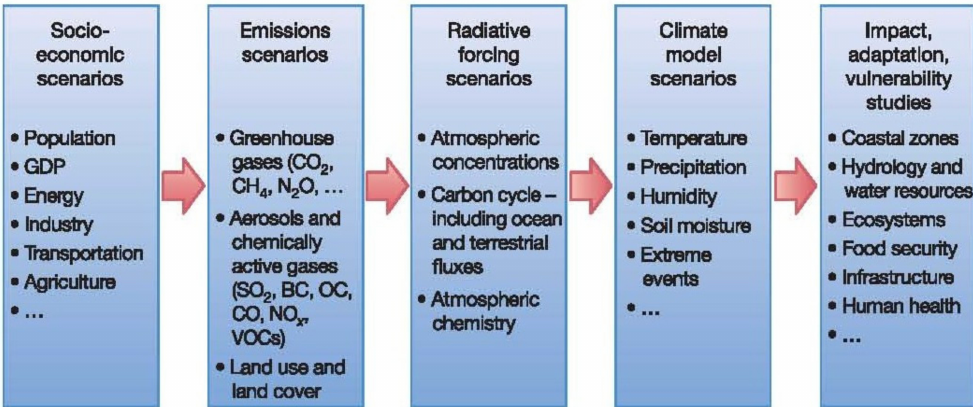
Figure 7. This figure depicts a linear chain of causes and consequences of anthropogenic climate change. Scenarios are developed on the basis of this sequence and handed from one research community to the next. From [69] with an edited